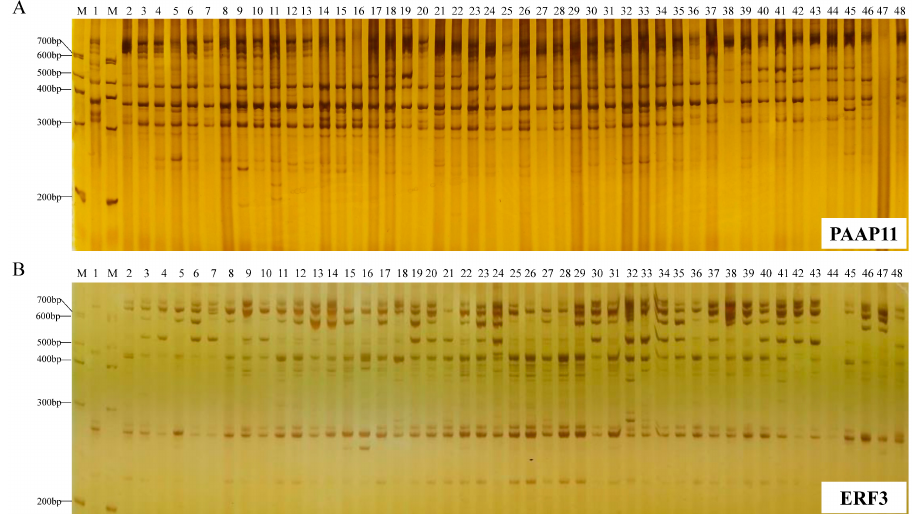
Figure 3. Amplification profiles of representative PAAP ( A ) and CDDP ( B ) markers. Lane 1–48 = JP8, JP40, JP55, JP59, JP64, JP84, JP91, JP103, JP108, JP109, JP118, JP119, JP128, PB1, PB2, PB7, PB17,